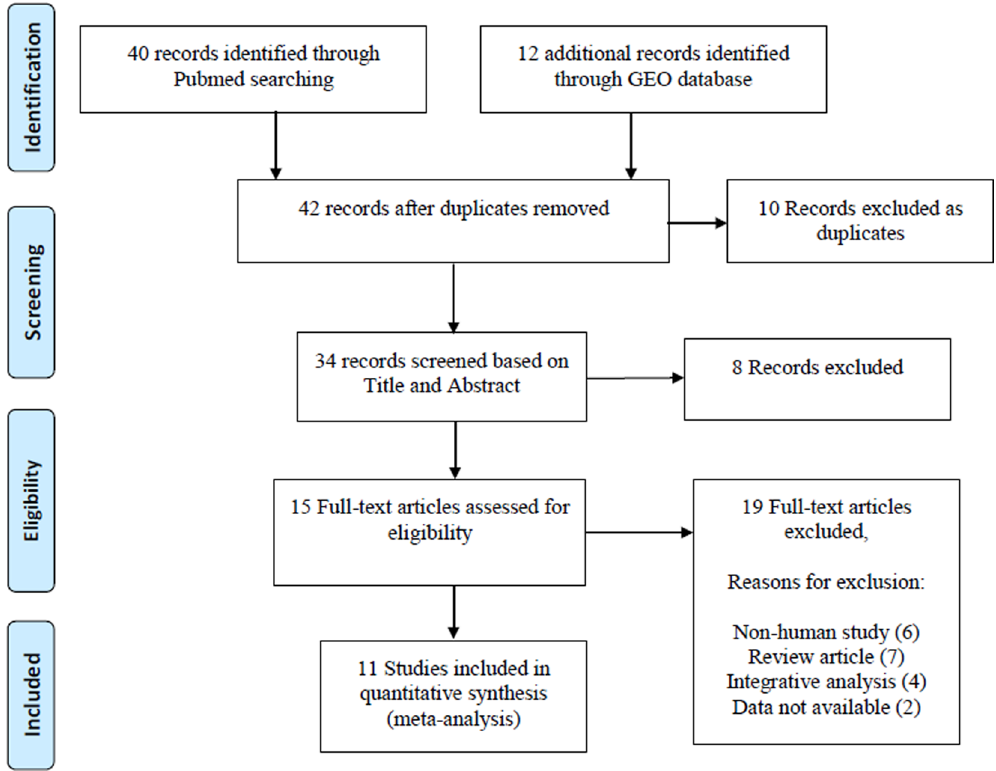
Figure 1. Flowchart of the selected process of microarray datasets for the meta-analysis.